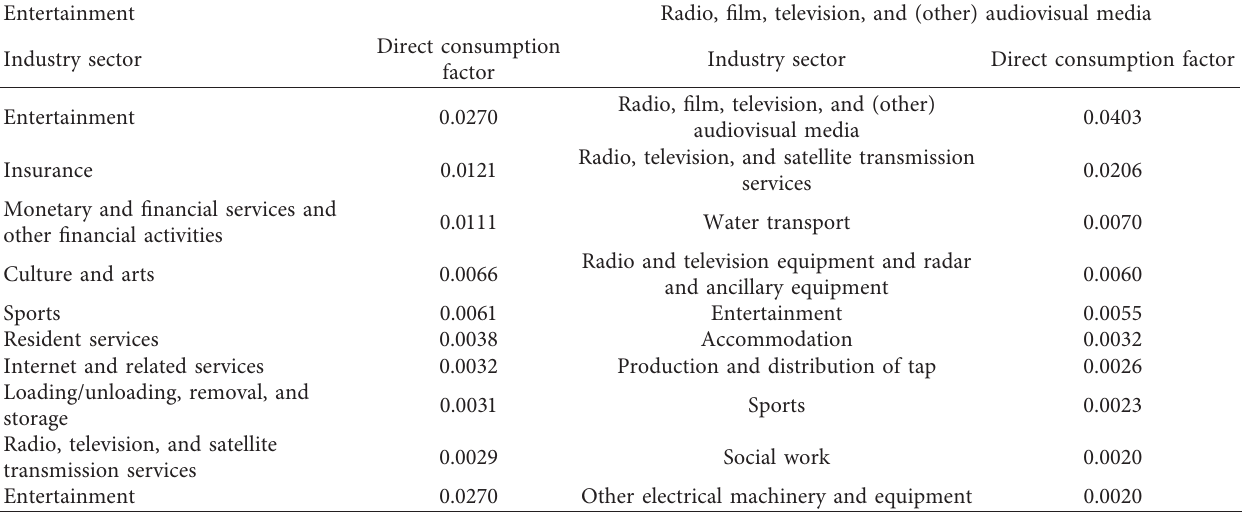
Table 2: Statistical table of direct distribution coefficients of the Chinese entertainment industry to other industrial sectors. Entertainment